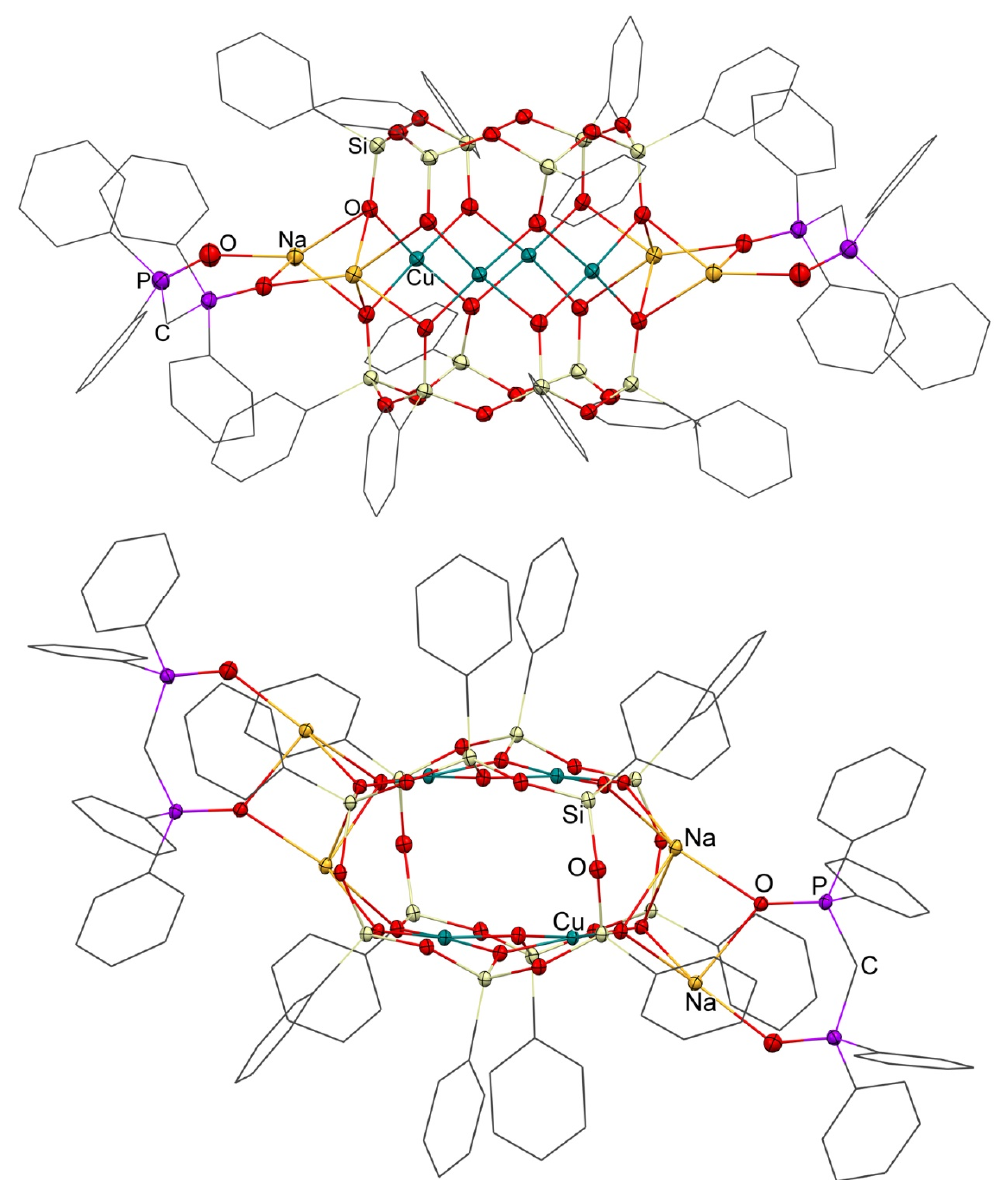
Figure 3. The molecular structure of 1 . Top : Front view. Bottom : Top view. Color code: copper—green, sodium—yellow, oxygen—red, phosphorous—purple.